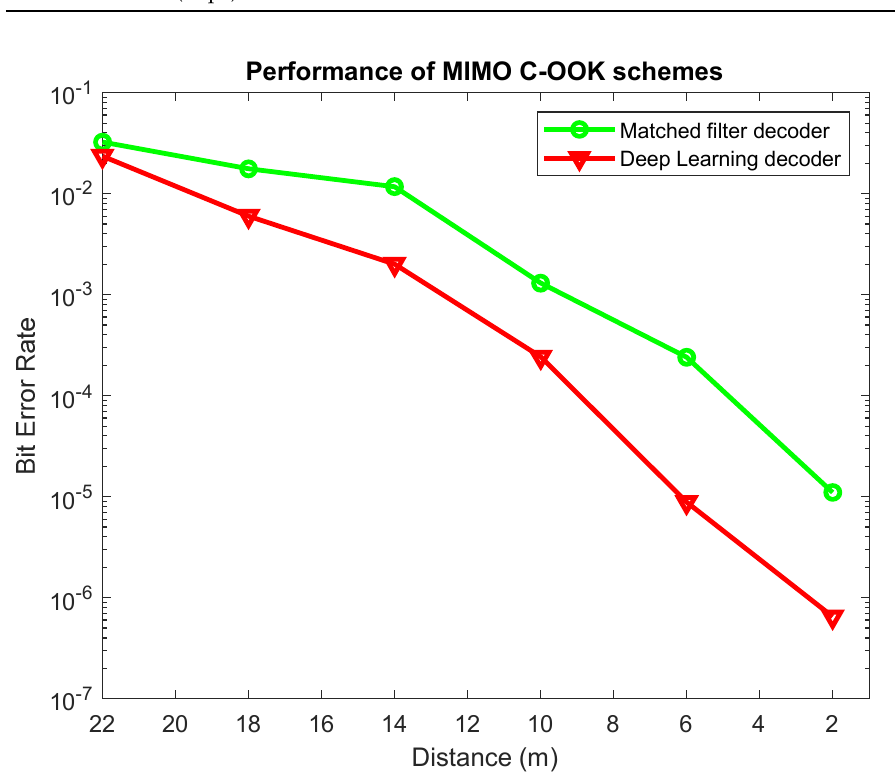
Figure 17. The BER performance of the MIMO C-OOK system with a matched filter and a deep learning neural network decoder with different distances considering a velocity of 2 m/s.